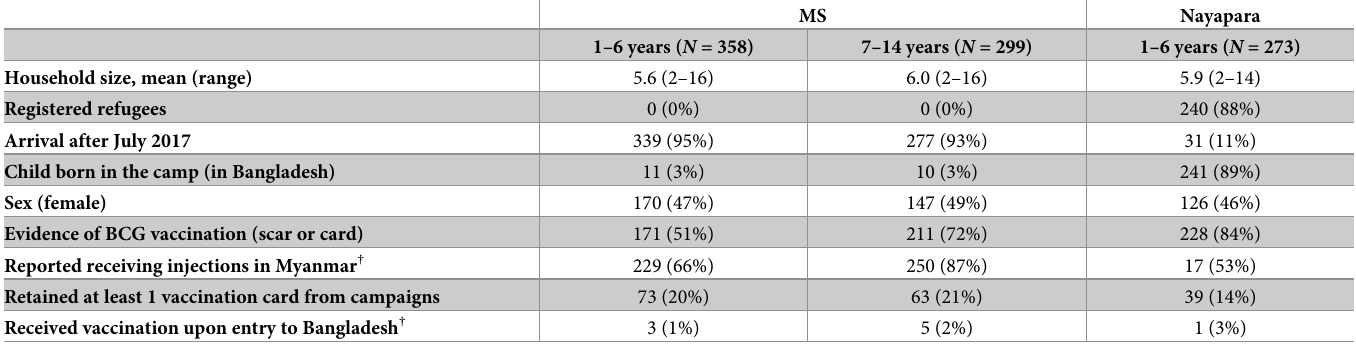
Table 2. Demographic characteristics and historical vaccination status, � by geographic area and age group, serologic and vaccination coverage survey among Rohin- gya children, Cox’s Bazar, Bangladesh, 2018.